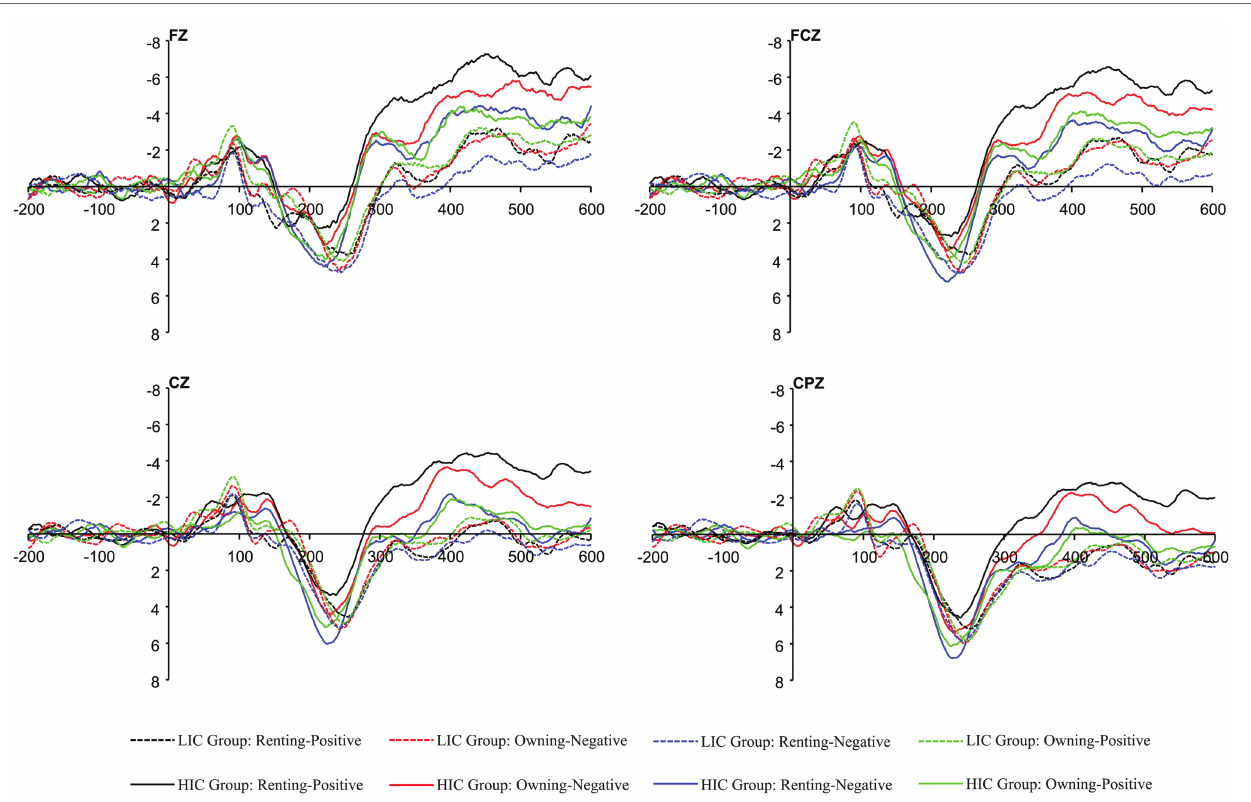
FIGURE 5 | Grand-average N400 ERPs waveforms evoked by adjectives at four electrodes (Fz, FCz, Cz, and CPz) in the high Confucian culture influence (HIC) and low Confucian culture influence (LIC)